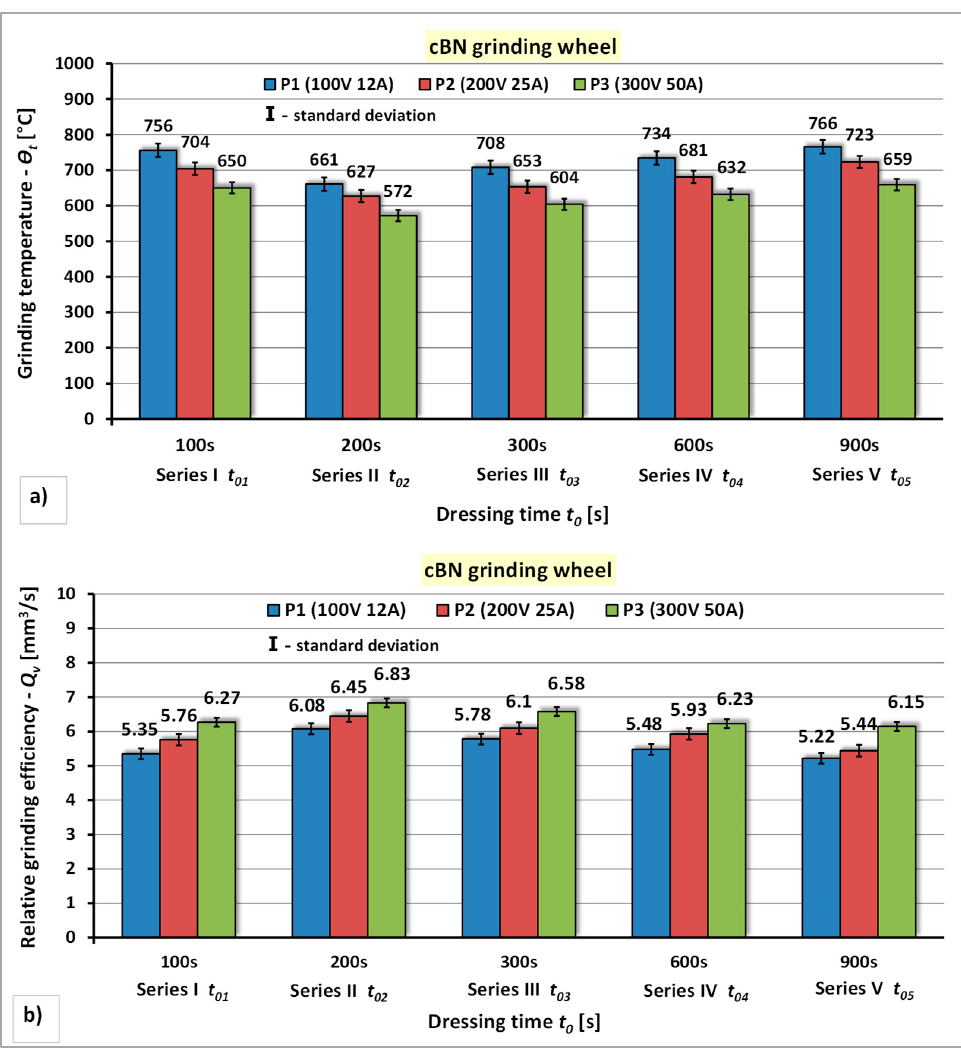
Figure 10. The effect of the generator power and unit infeed time during electrodischarge dressing of a cBN grinding wheel using a rotating electrode: ( a ) On the grinding temperature— Θ t ; ( b ) On the relative grinding efficiency— Q v .